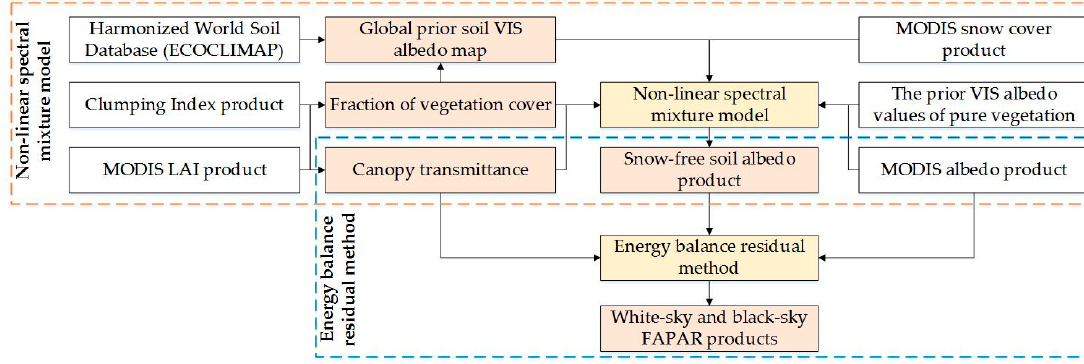
Figure 1. The flowchart of the energy balance residual method to generate the white-sky and black- sky FAPAR products using the MODIS datasets.